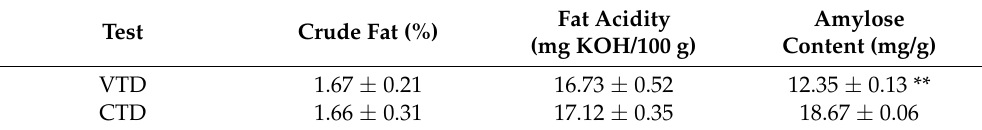
Figure 3. Quality indicators for the appearance of rice under different drying methods: ( a ) the husked rice yield of the paddy rice dried at VTD and CTD; ( b ) the fissuring rate of the paddy rice dried at VTD and CTD; ( c ) the head rice yield of the paddy rice dried at VTD and CTD; ( d ) total color difference value ( ∆ E ) of the paddy rice dried at VTD and CTD. Table 6. Chemical indicators of the paddy